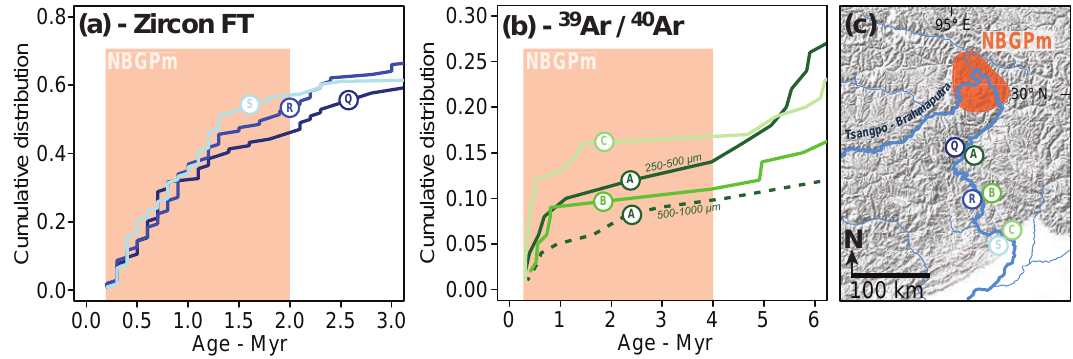
Figure 8. (a) Zircon fission track (Enkelmann et al., 2011) and (b) 39 Ar / 40 Ar (Lang et al., 2016) of sediment samples from the Tsangpo- Brahmaputra downstream to the NBGPm (c) (trimmed to the younger part of the sample age